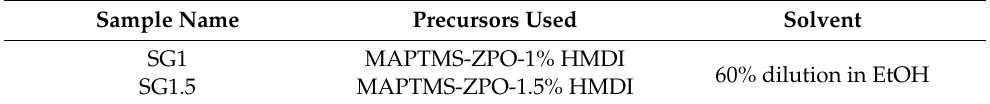
Table 1. Constituents of the